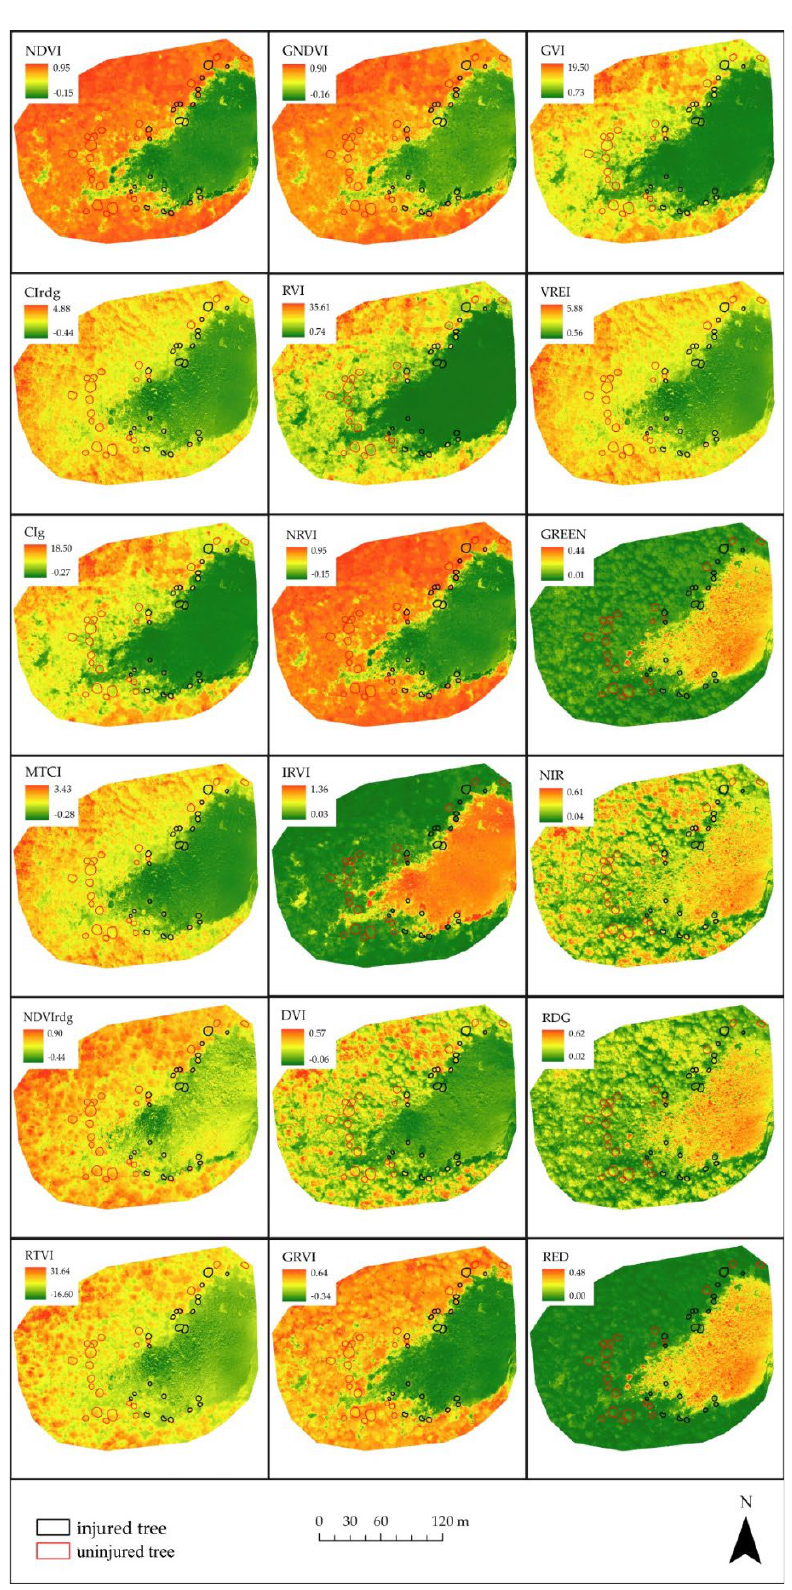
Figure A5. The maps of all vegetation indices (VIs) and individual spectral bands for the Cerkev site (14 August 2020).